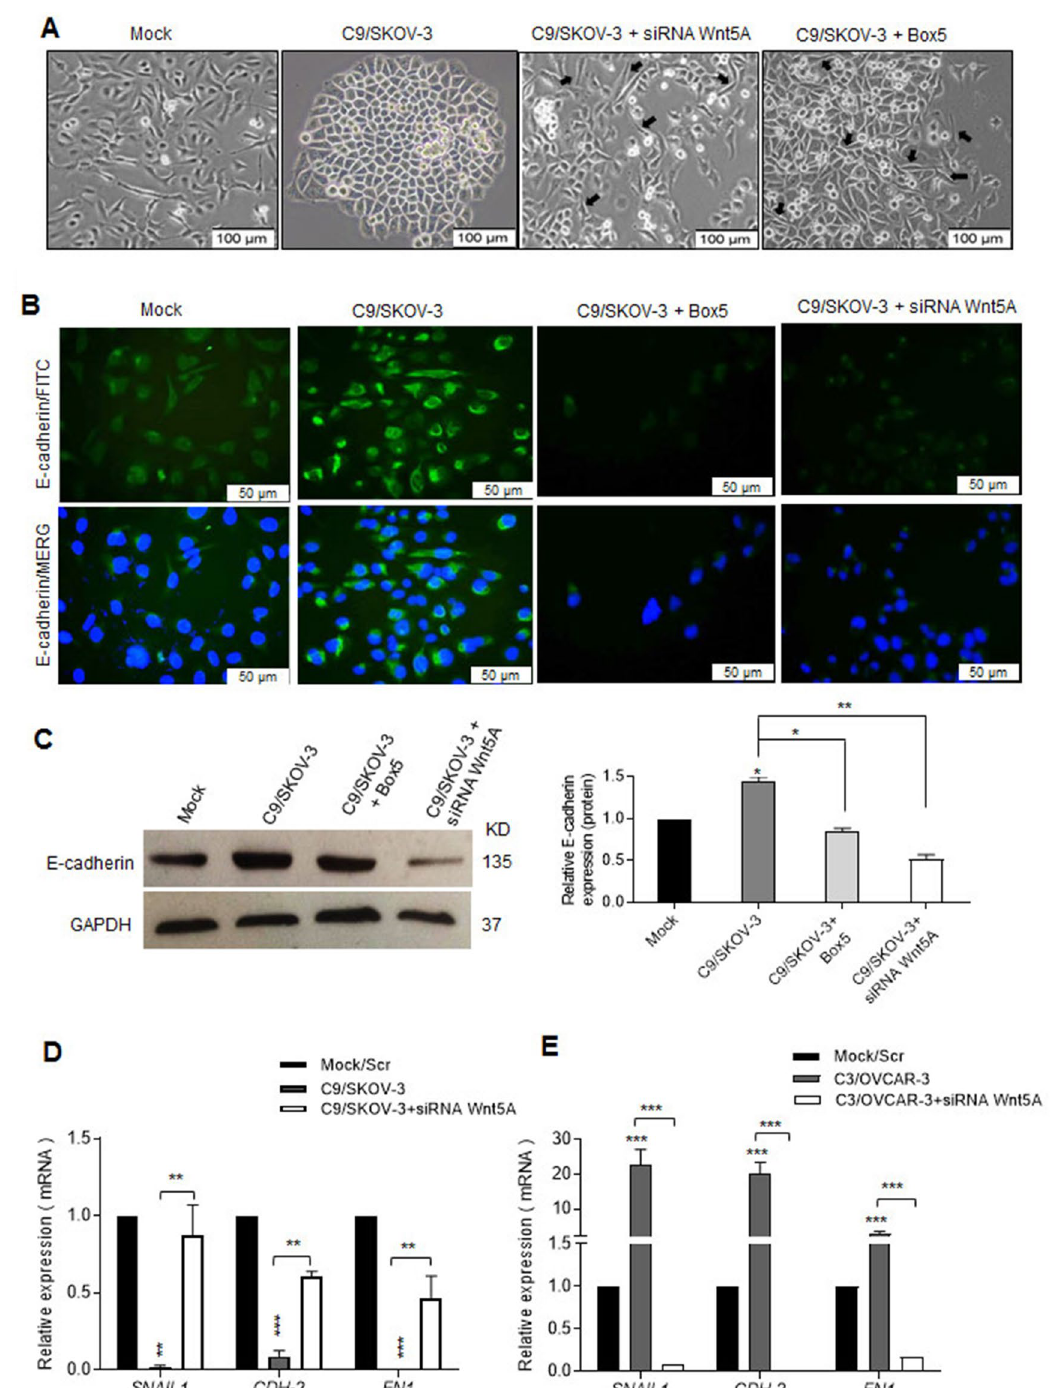
Figure 2. Wnt5A overexpression modulates mesenchymal markers and reverts the mesenchymal morphology of SKOV-3 cells. ( A ) C9/SKOV-3 clone showed epithelial-like morphology compared to spindle morphology of non-transfected cells. Wnt5A knock-down or blocking with Box5 partially rescued morphology alteration of C9/SKOV-3 clone (arrows) (scale bar: 100 µm). ( B,C ) C9/SKOV-3 clone showed increased E-cadherin immunostaining and expression compared to mock that was reverted using siRNA Wnt5A or Box5 (scale bar: 50 µm). The bands corresponding to GAPDH of the same blot was added separately. ( D ) Decreased mRNA levels of the mesenchymal markers CDH-2, SNAIL, and FN1 in C9/SKOV-3 clone compared to the mock which was reversed with siRNA Wnt5A. ( E ) The increased expression level of mesenchymal markers in C3/OVCAR-3 clone compared to mock which was reverted in Wnt5A knock-down. Results of RT-qPCR were normalized related to GAPDH used as an internal control. Mean ± SD of at least three independent experiments. * P < 0.05; ** P < 0.01; *** P < 0.001 compared to